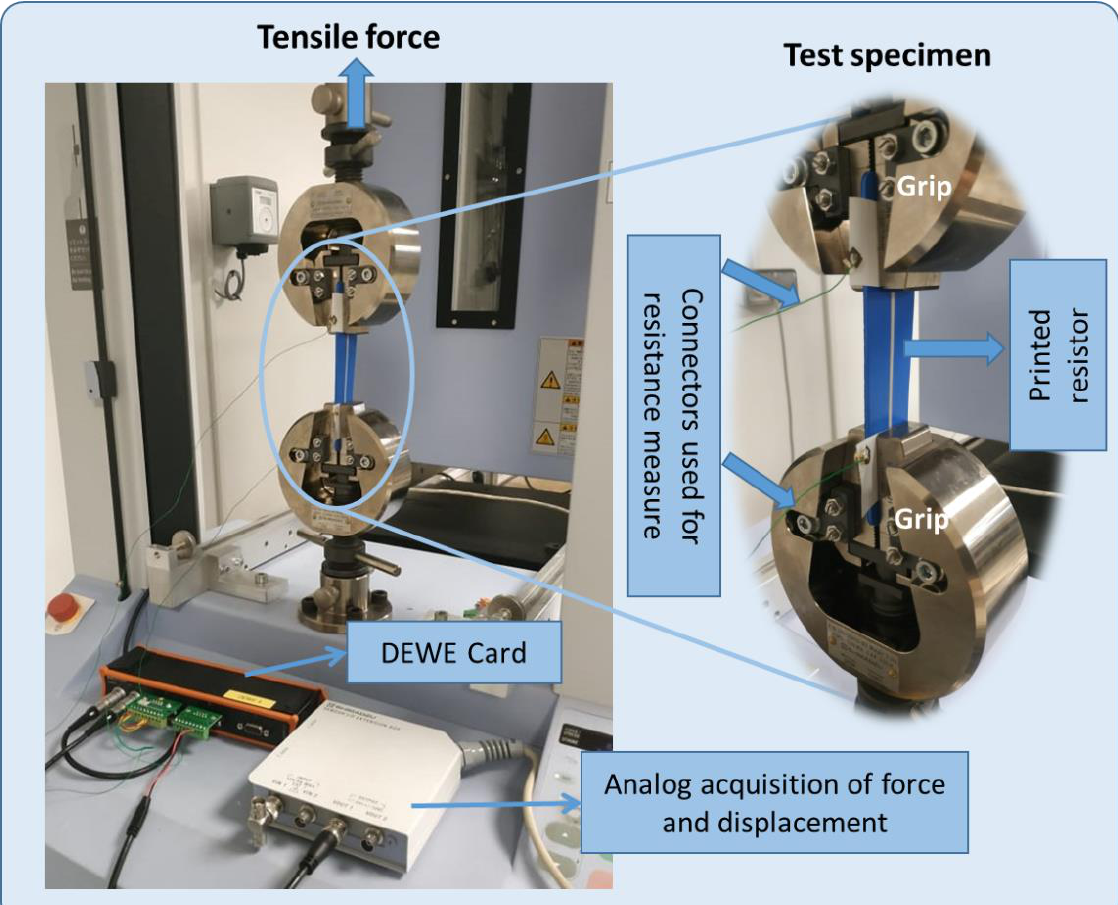
Figure 6. Experimental setup used for a piezoresistive characterization of 2D coated samples. Knowing the speed of the tensile test (denoted v where v = dx / dt ), it is possible to deduce the strain rate, given by: